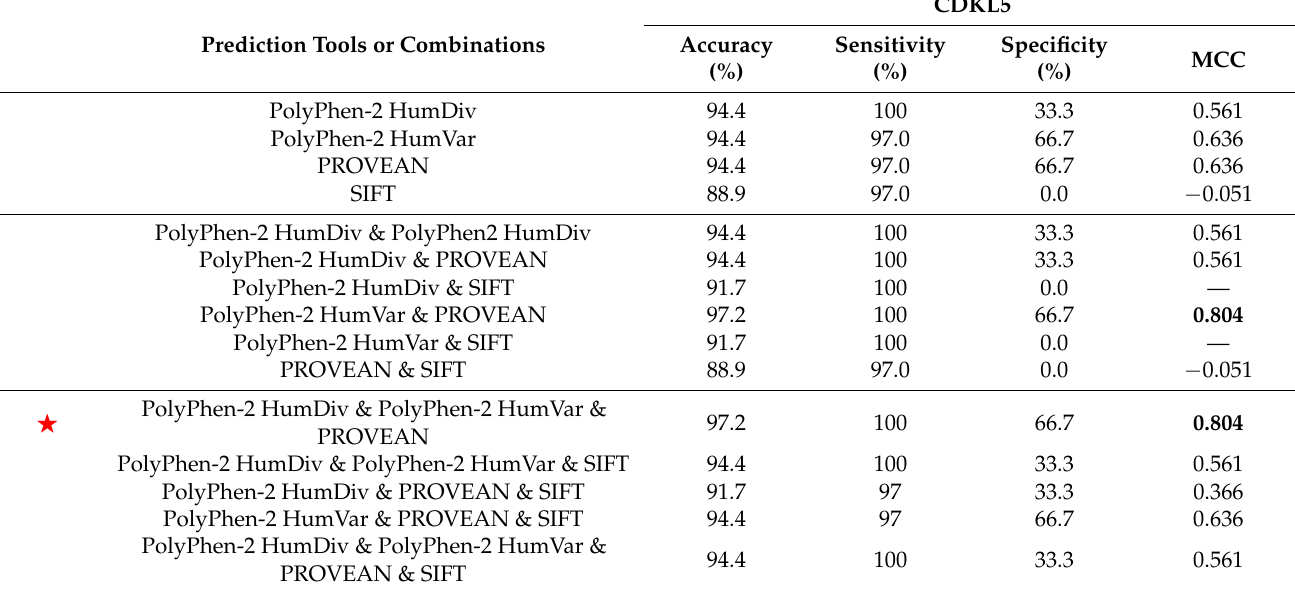
Table 3. The accuracy, sensitivity, specificity, and MCC (Matthew’s correlation coefficient) scores of all combinations of in silico prediction tools for CDKL5